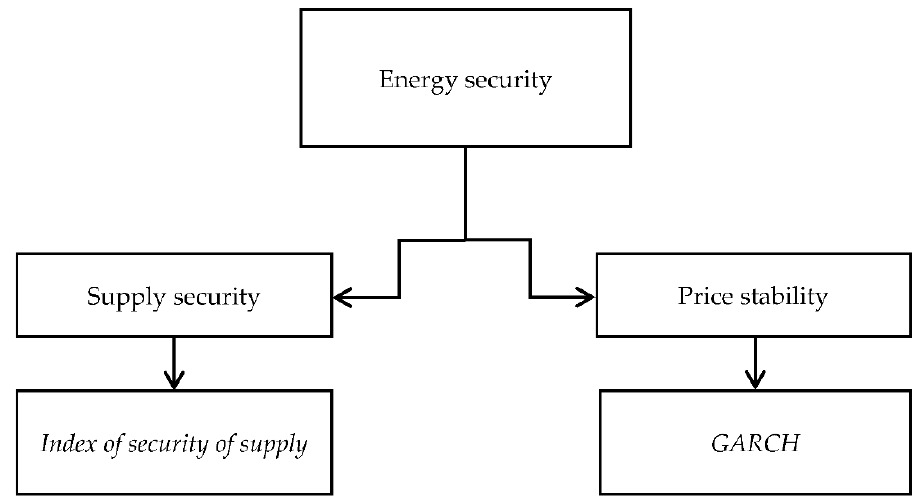
Figure 1. Energy security components: methodological approach.